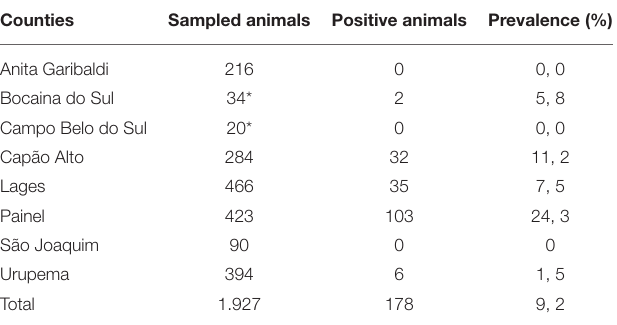
TABLE 2 | Prevalence of Fasciola hepatica through egg research in fecal samples of naturally infected cattle in municipalities in the Serrana Mesoregion, between 2019 and 2021.